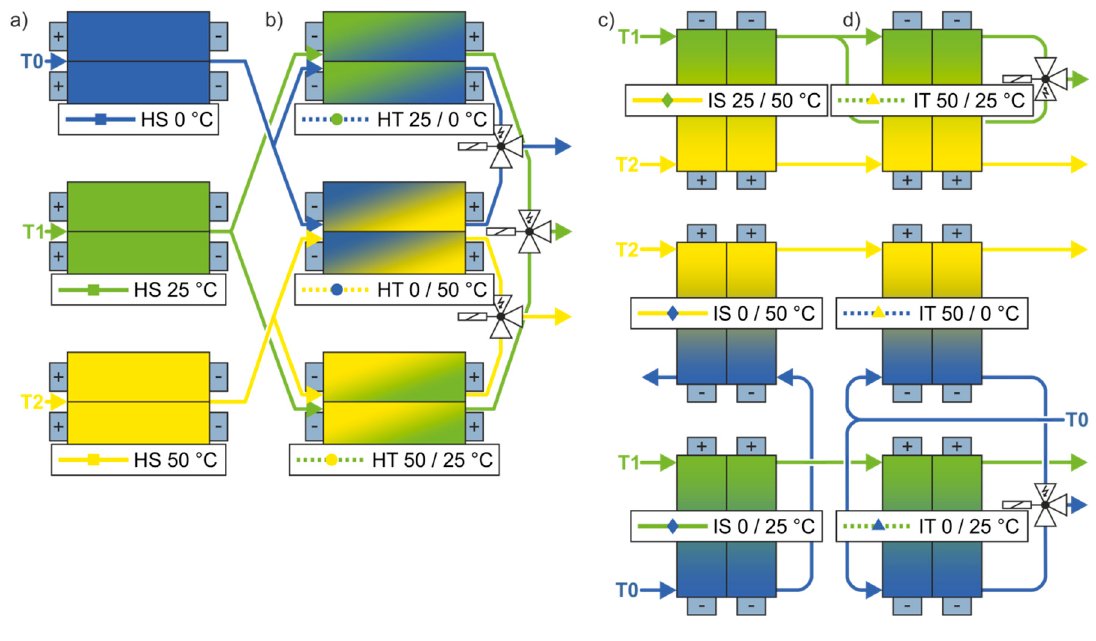
Figure 1. Flow diagrams of the homogeneous ( a ) steady (HS) and ( b ) transient (HT) setups as well as inhomogeneous ( c ) steady (IS) and ( d ) transient (IT) setups [1].